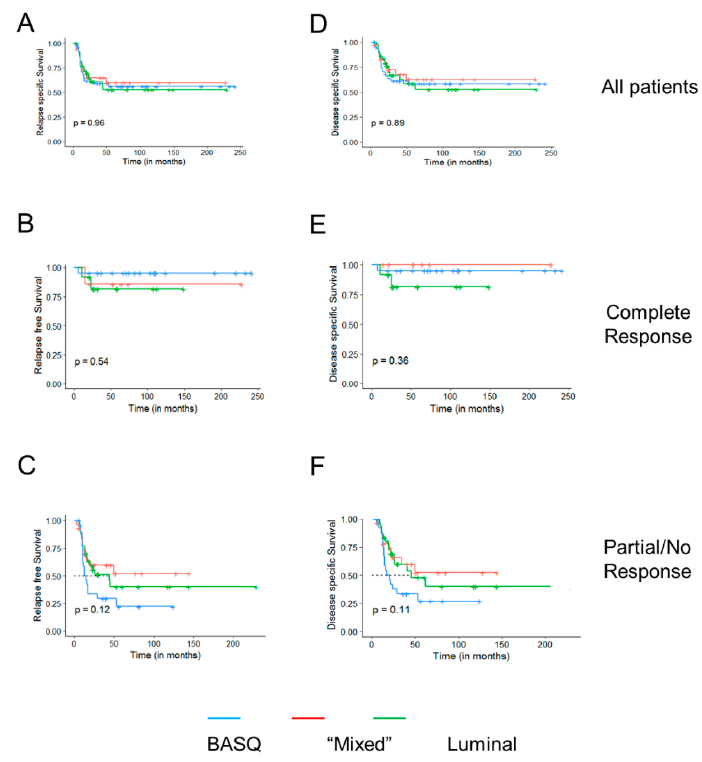
Figure 3. Kaplan–Meier relapse-free survival ( A–C ) and disease-specific survival ( D–F ) curves for all patients ( A , D ), patients undergoing a pathological complete response (pCR) ( B , E ), or partial / non-responders ( C , F ) according to the three tumor subtypes.